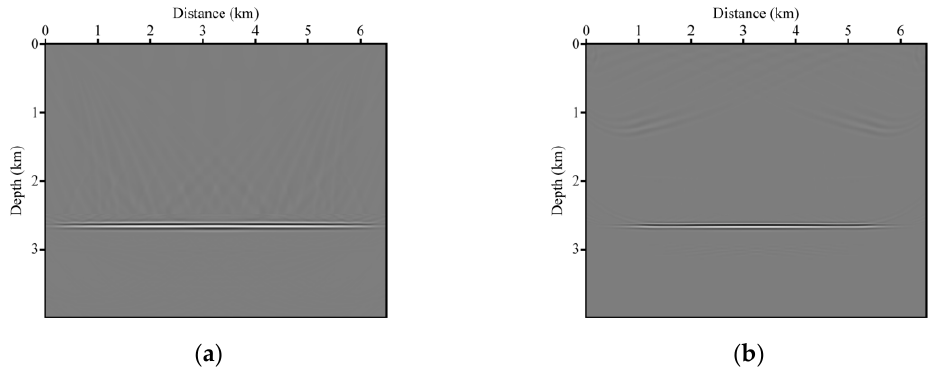
Figure 4. ERTM image obtained based on the VDWE: ( a ) PP imaging; ( b ) PS imaging.